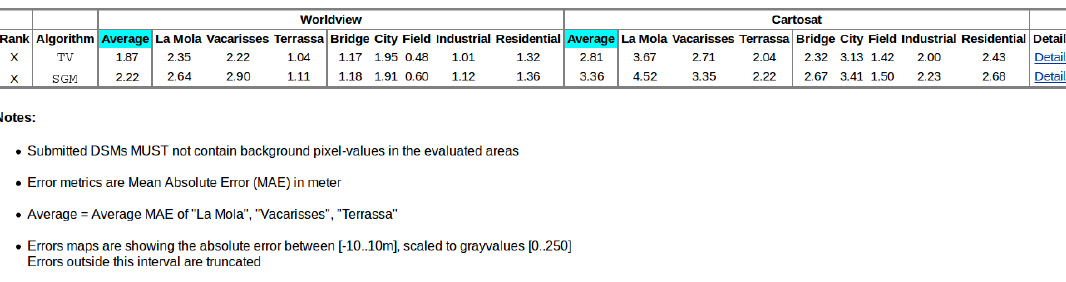
Figure 6: Evaluation results (22.10.2014) for two stereo algorithms: SGM and TV - see Section 4. for